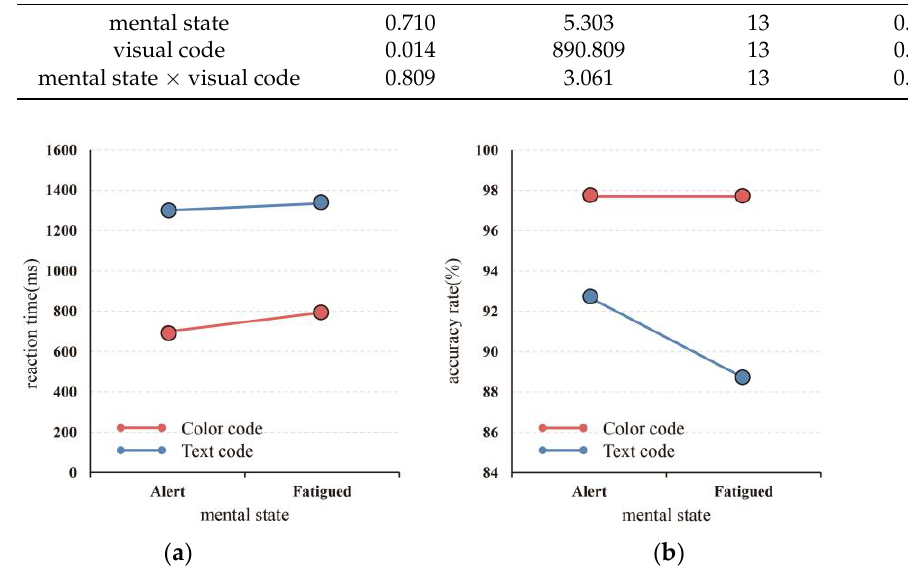
Figure 6. ( a ) Accuracy rate of mental state × visual code. ( b ) Reaction time of mental state × visual code.